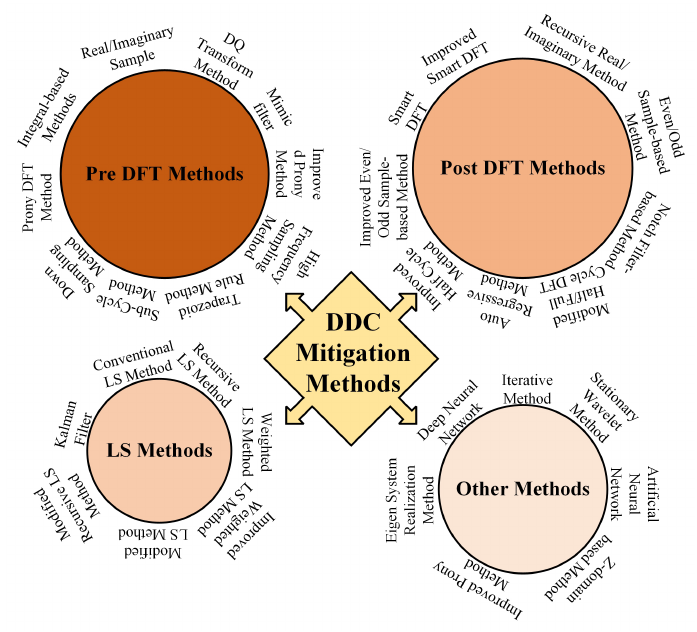
Figure 3. Different Methods of DDC mitigation in the current phasor estimation